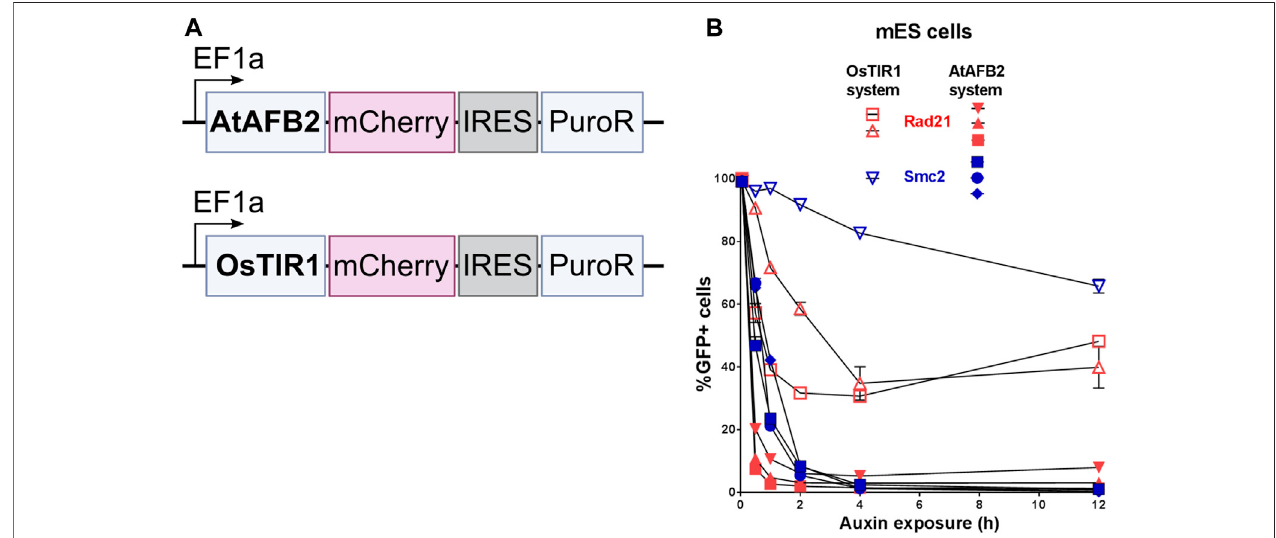
FIGURE 4 | Comparison of degradation ef fi ciency with AFB protein driven by the same EF1a promoter. (A) Scheme of genetic constructs used. (B) Dynamics of POI depletion in mESC clones (Rad21 colored in red; Smc2 colored in blue). Vectors expressing AFB proteins: pSH-EFIRES-P-OsTIR1-mCherry-weak NLS and pSH- EFIRES-P-AtAFB2-mCherry-weak NLS, were randomly integrated. For this analysis, all clones were grown in puromycin, and the proportion of Cherry-positive cells in each of them was more than 95%. For each clone, the measurement was carried out twice.